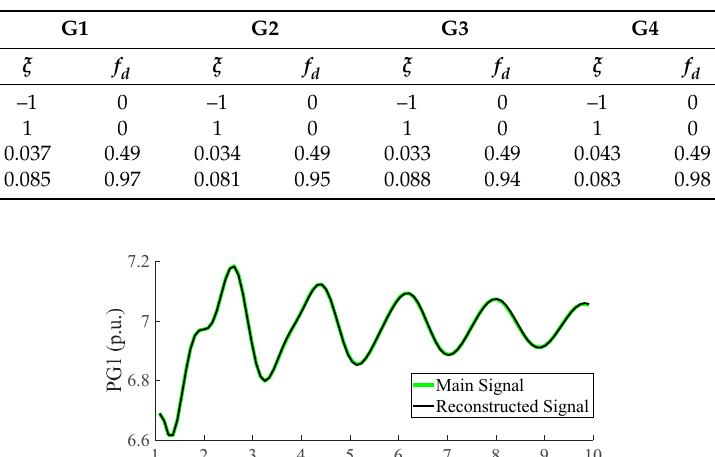
Figure 7. Kundur’s two-area test system [1].